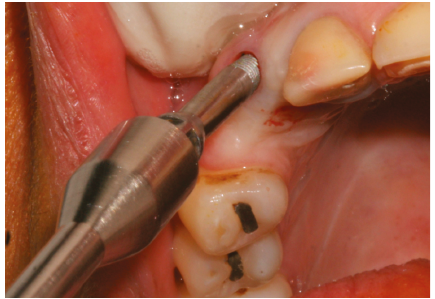
Figure 1: Temporary crown on teeth 11 adapted to the removable prosthesis.